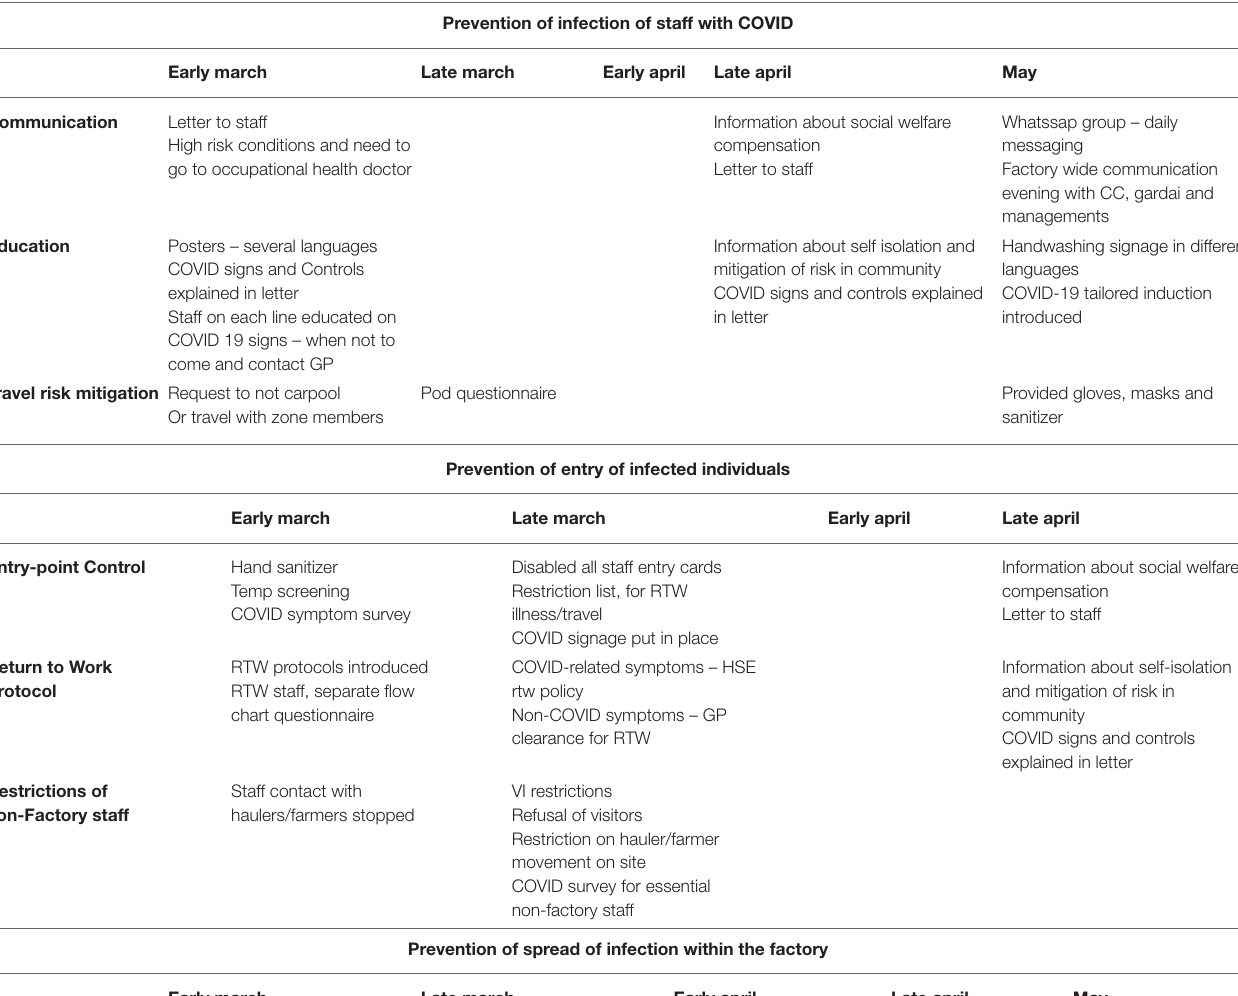
TABLE 2 | Progressive timing of implementation of risk mitigation measures, classified as prevention of infection, prevention of entry of infected individuals, prevention of spread of infection, and high-level management